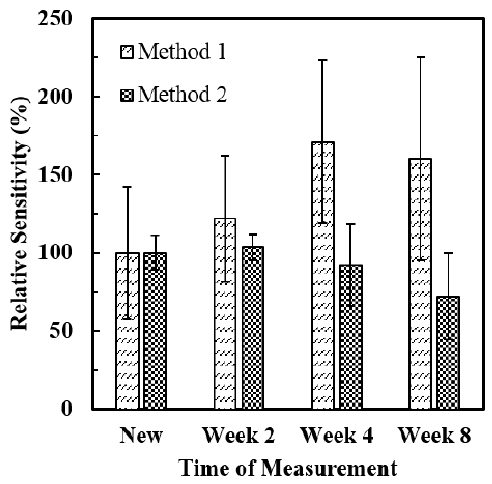
Figure 8. The storage stability of ALT biosensors tested by both methods. The relative sensitivity of ALT biosensors ( N = 5) was plotted vs. time of measurement.